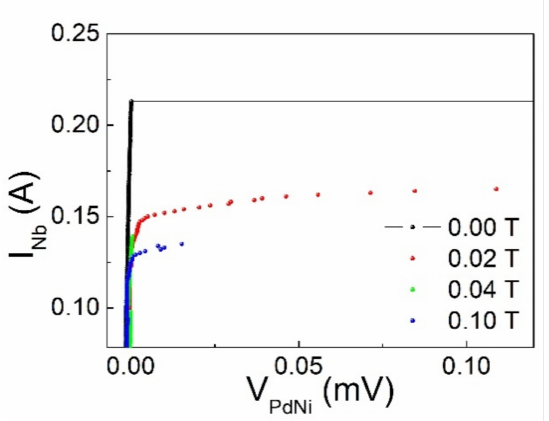
Figure 2. I–V curves at T = 4.2 K at different applied magnetic fields for a Nb/Al 1 − x O x /Pd 0.84 Ni 0.16 trilayer in the case of current sent in